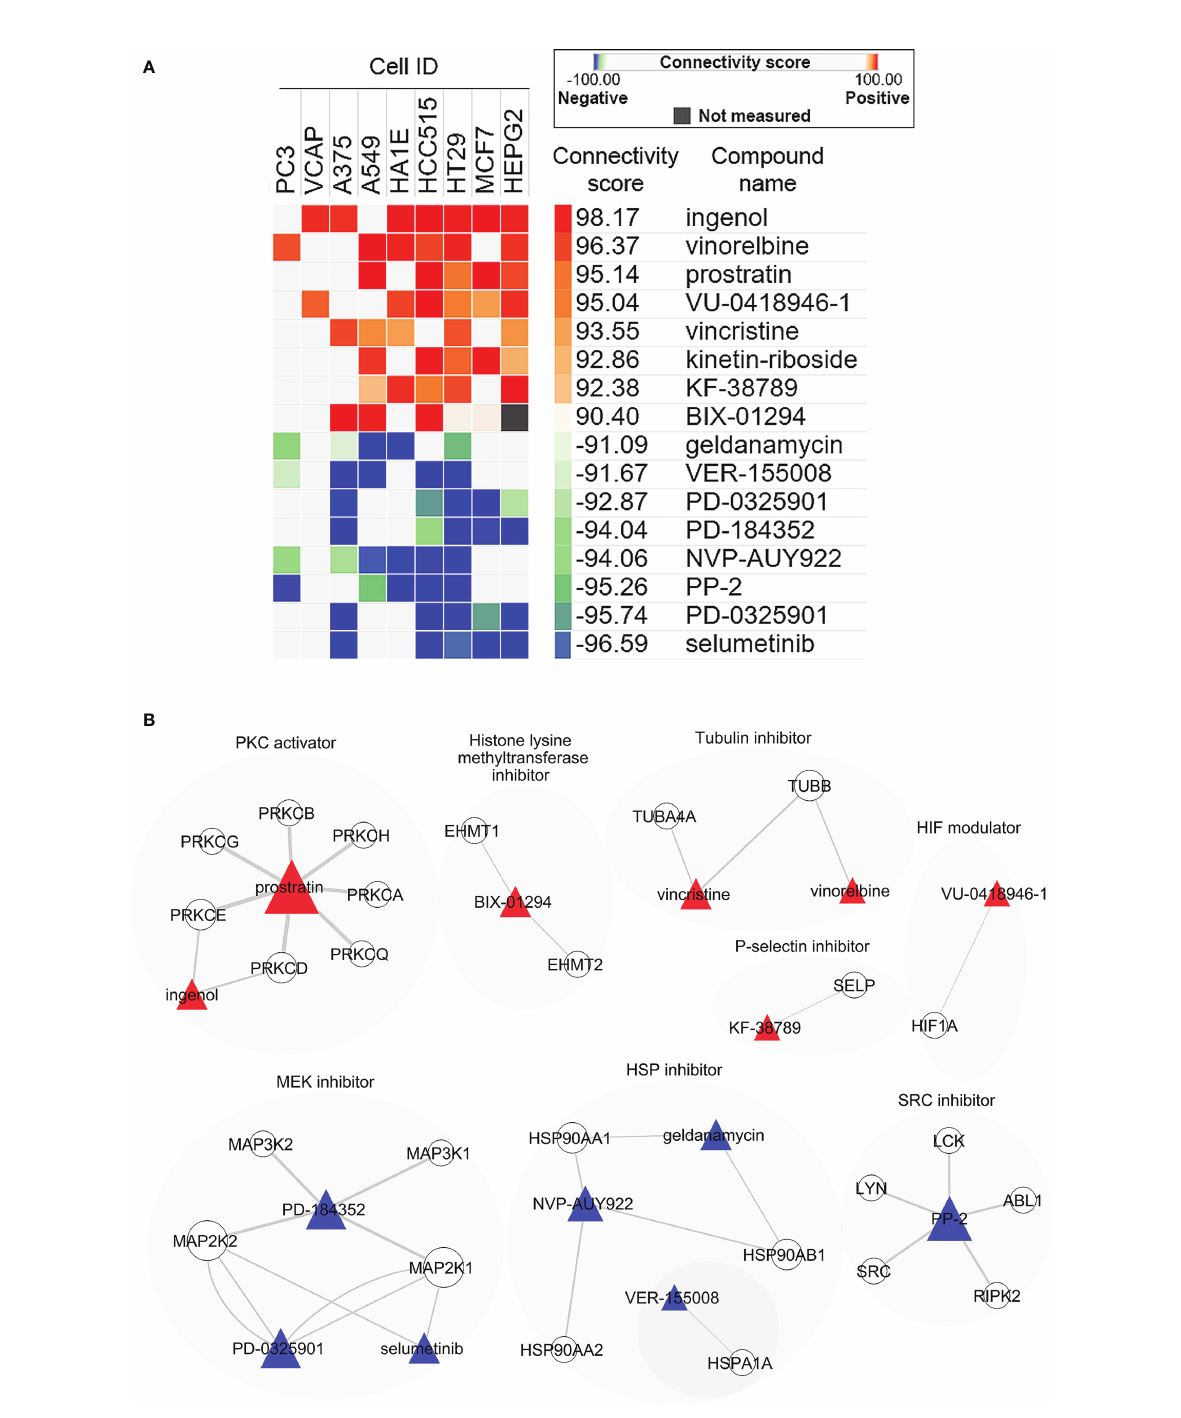
FIGURE 3 Connectivity Map (CMap) analysis in MDA-MB-468 cells exposed to bioactive extracts from Limonium Sinense . (A) Heatmap showing the connectivity score for the most signi fi cant compounds in 9 cell lines. Cell ID, compound name (Perturbegan), connectivity score (and the colour key), mechanism of action, and target genes for each compound are indicated. Compounds are considered signi fi cantly connected with the reference signature when the connectivity score is above 90 (similar) or below -90 (opposite). Compounds are sorted by the decreasing order of their connectivity scores. (B) Graph showing the interaction network between compounds and their target genes. The colours and shapes represent the indicated compounds and their target genes. The sizes of the nodes indicated the degrees that the nodes connect to others, and the width of the lines represents the EdgeBetweenness of each